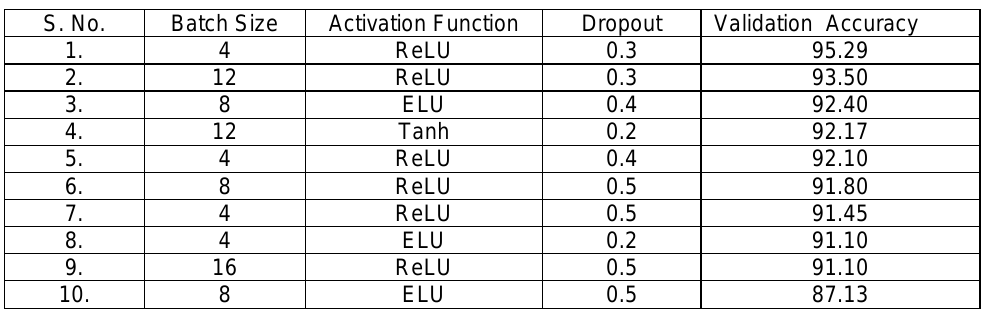
Table 5. Result of Optimized RSISC-16 Net Model